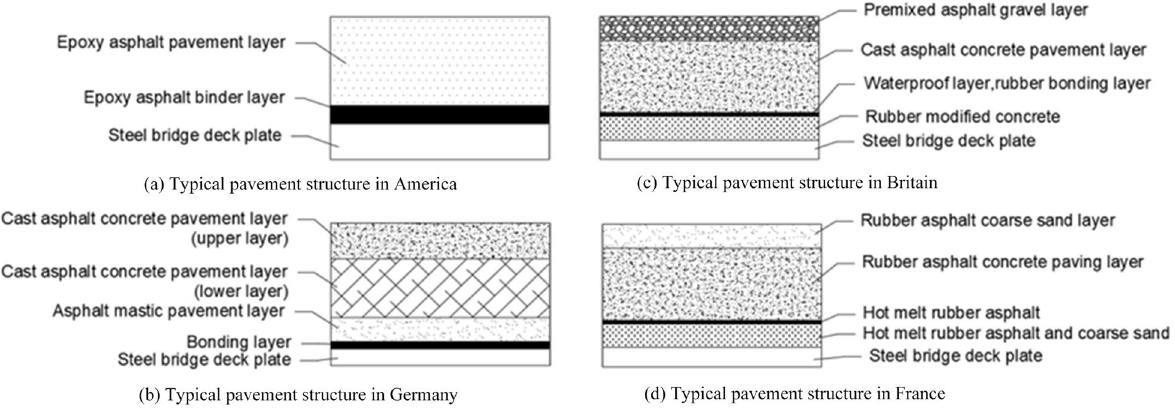
Figure 1. Typical pavement structures of steel bridge deck. ( a ) Typical pavement structure in America; ( b ) typical pavement structure in Germany; ( c ) typical pavement structure in Britain; ( d ) typical pavement structure in